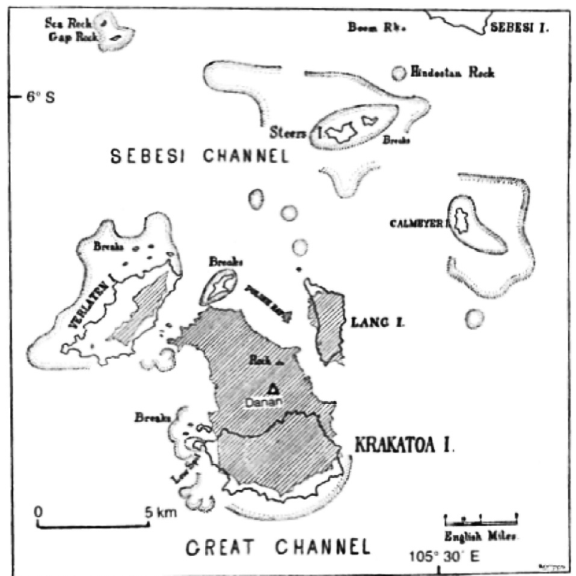
Figure 1. Chart of Krakatau and the surrounding islands, from the chart surveyed immediately after the eruption [from Judd 1888, fig. 11]. The shaded areas show the form of the islands drawn in the old chart. Dotted lines show sandbanks and lines of breakers. “Danan” is added by the present author.